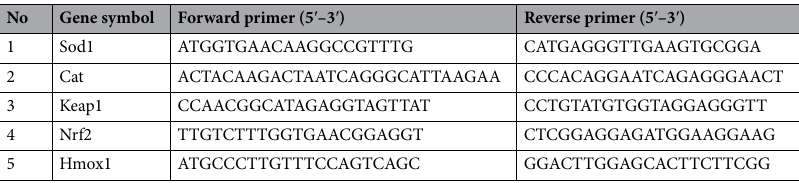
Table 1. The sequences of primer pairs used in real-time quantitative PCR